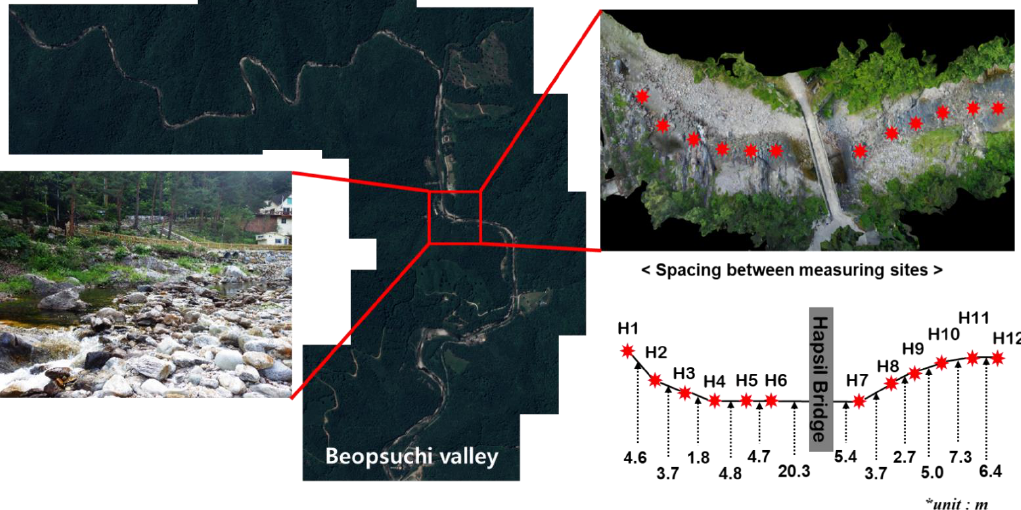
Figure 1. Location of the 12 field reaches in the Namdae Stream, Yangyang, South Korea, using a Drone (INSPIRE 1).